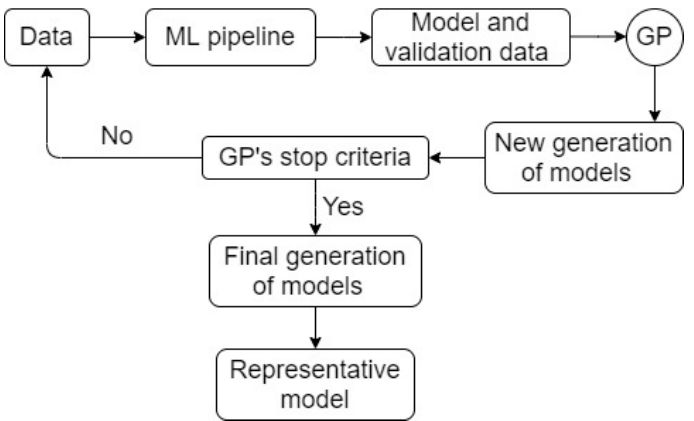
Figure 7. Schematic of TPOT for automatic machine learning.